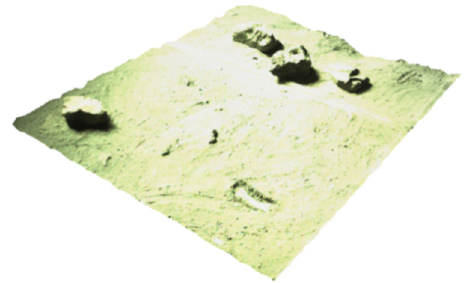
Figure 16. The 3D model of lunar surface environment.